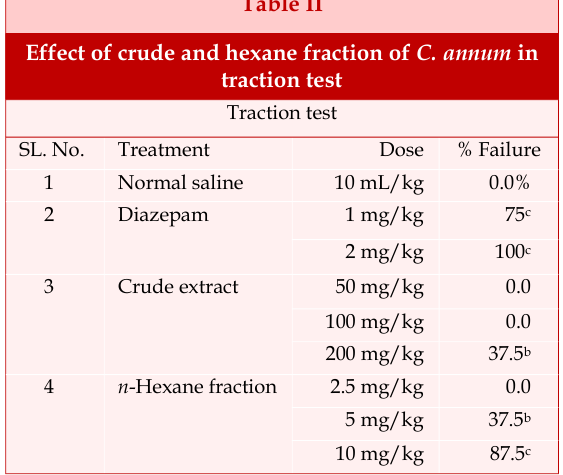
Effect of crude and hexane fraction of C. annum in